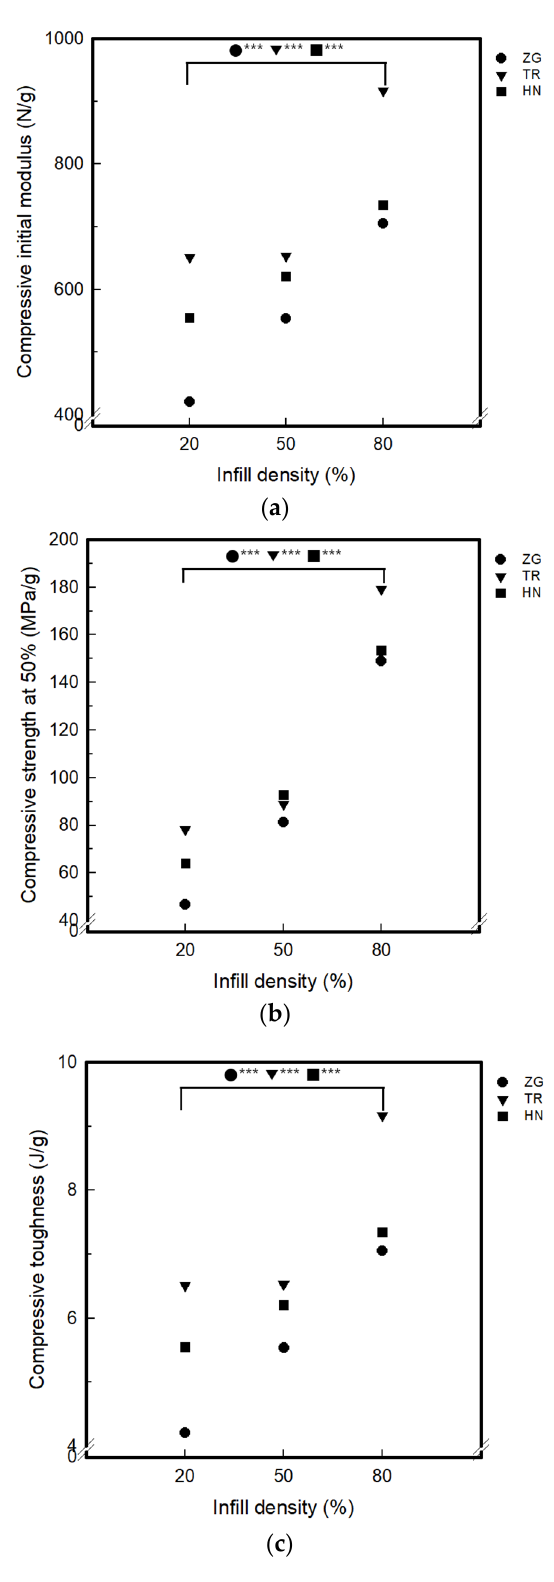
Figure 5. The compressive properties of the coated 3DP fi ngertips with various in fi ll pa tt erns and densities ( p -value: *** p < 0.001): ( a ) Compressive initial modulus; ( b ) Compressive strength at 50%; ( c ) Compressive toughness.